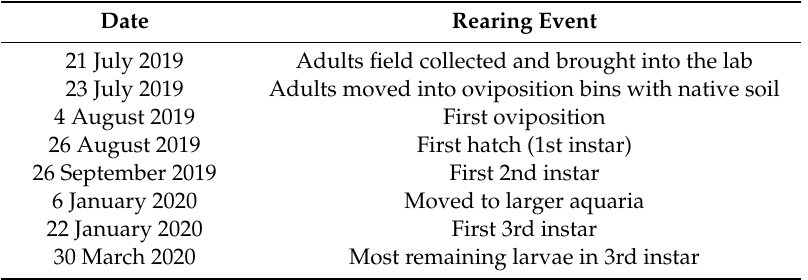
Table 1. Dates and main events in the course of rearing all instars of the cobblestone tiger beetle.